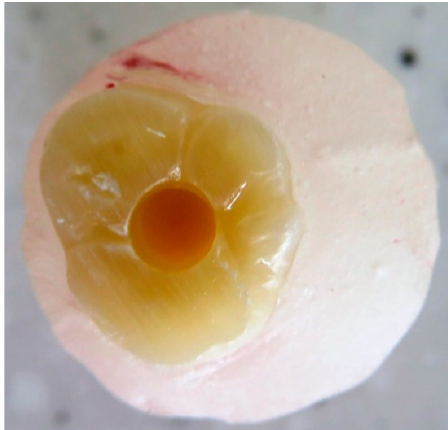
Figure 2. Standardized occlusal cavity with a 5 mm depth in an upper sound molar embedded in a cold-curing resin block up to directly below the cemento–enamel junction after the sealing of the